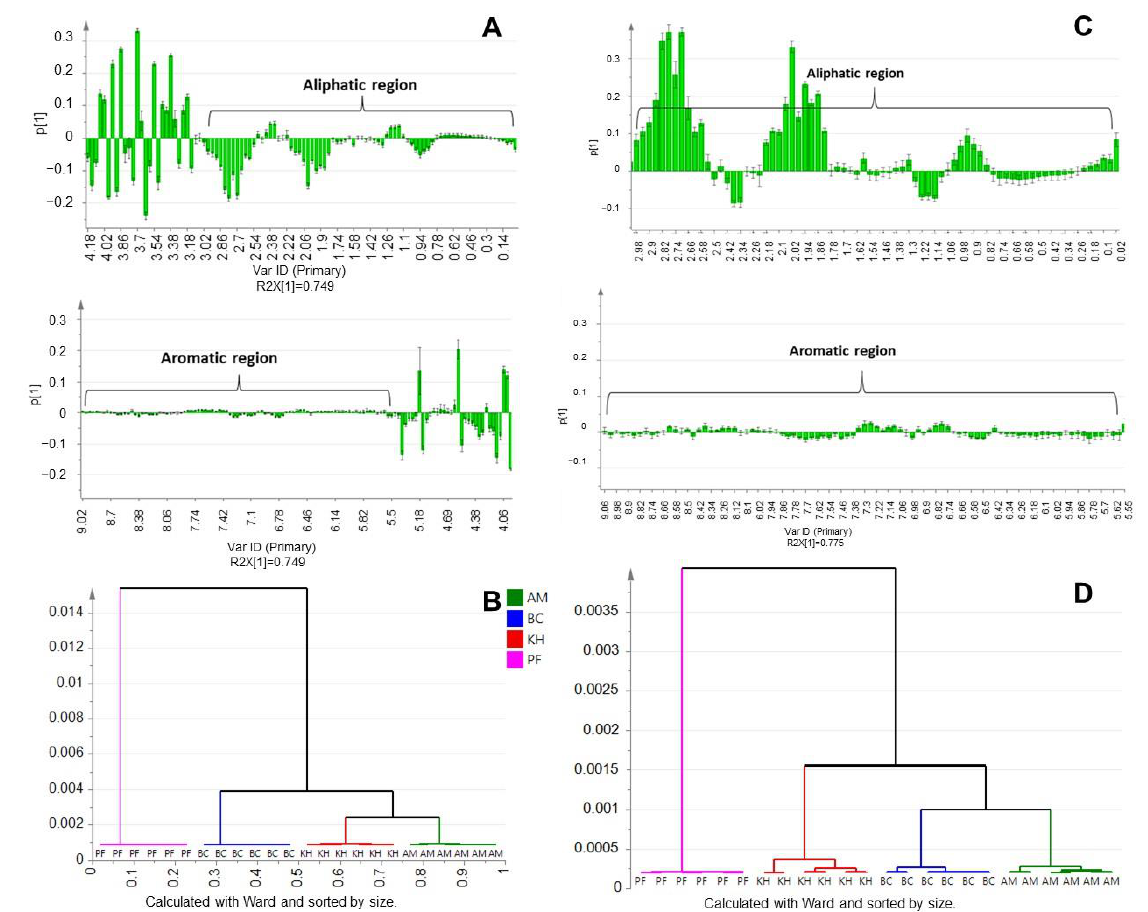
Figure 4. ( A ) PCA loading column plot of three different kiwifruits: Hayward (KH), Bidan (BC), A. arguta (AM) and persimmon Fuyu (PF). ( B ) Hierarchical cluster analysis (HCA) for KH, BC, AM and PF, based on group average cluster analysis of the different metabolite components. ( C ) PCA loading column plot for KH, BC, AM and PF after removing sugar regions. ( D ) HCA for KH, BC, AM and PF, based on group average cluster analysis of the different metabolite components after removing sugar regions.